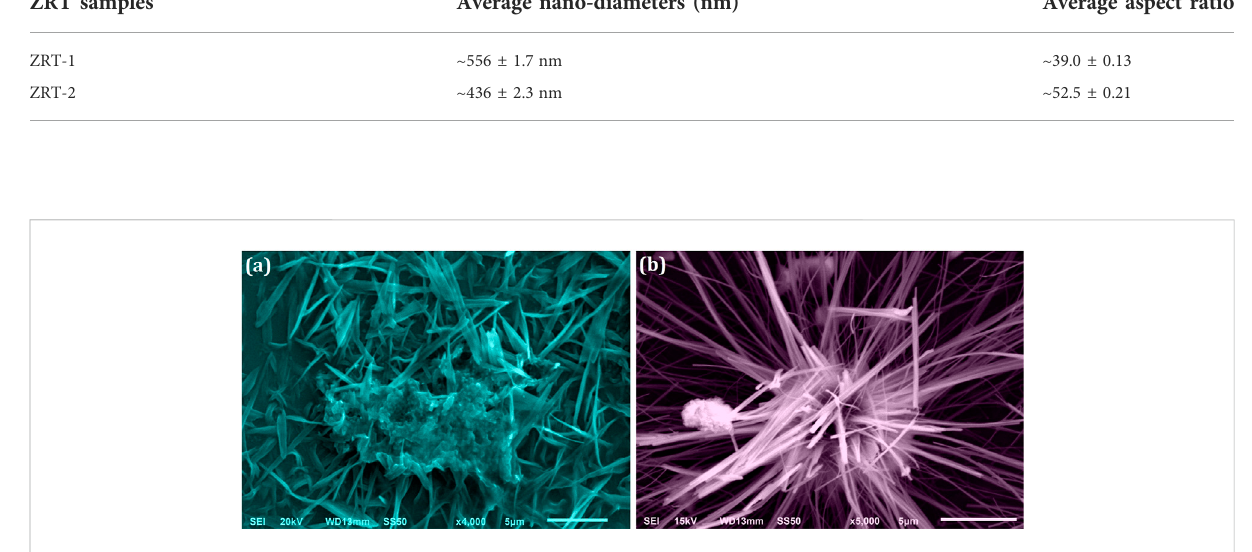
FIGURE 2 SEM image of ZRT samples prepared by varying reaction time of ion-carriers on the synthesis of zinc oxide nanoparticles (ZRTs): (A) ZRT-1 and (B) ZRT-2.